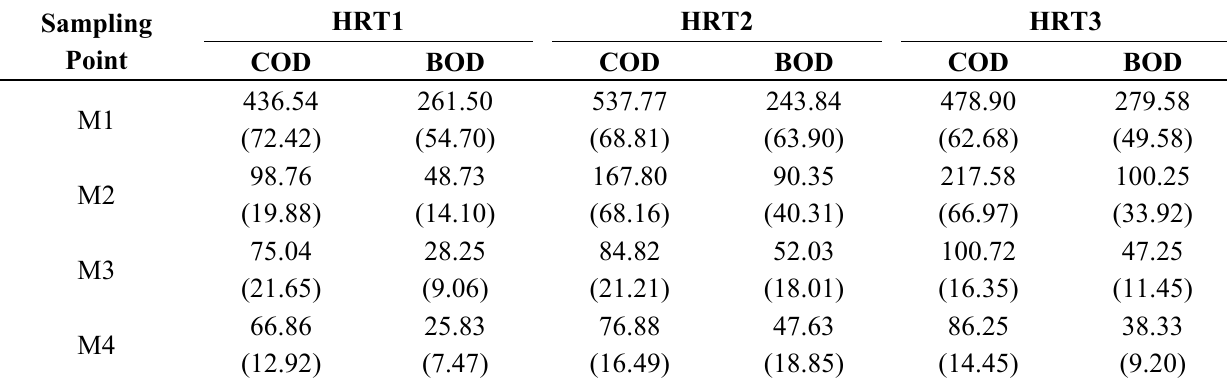
Figure 3. COD ( a ) and BOD ( b ) concentration for every sampling. Table 2. Mean values (±SD, n = 40) of COD and BOD (mg·L − 1 ) in every sampling point and HRT